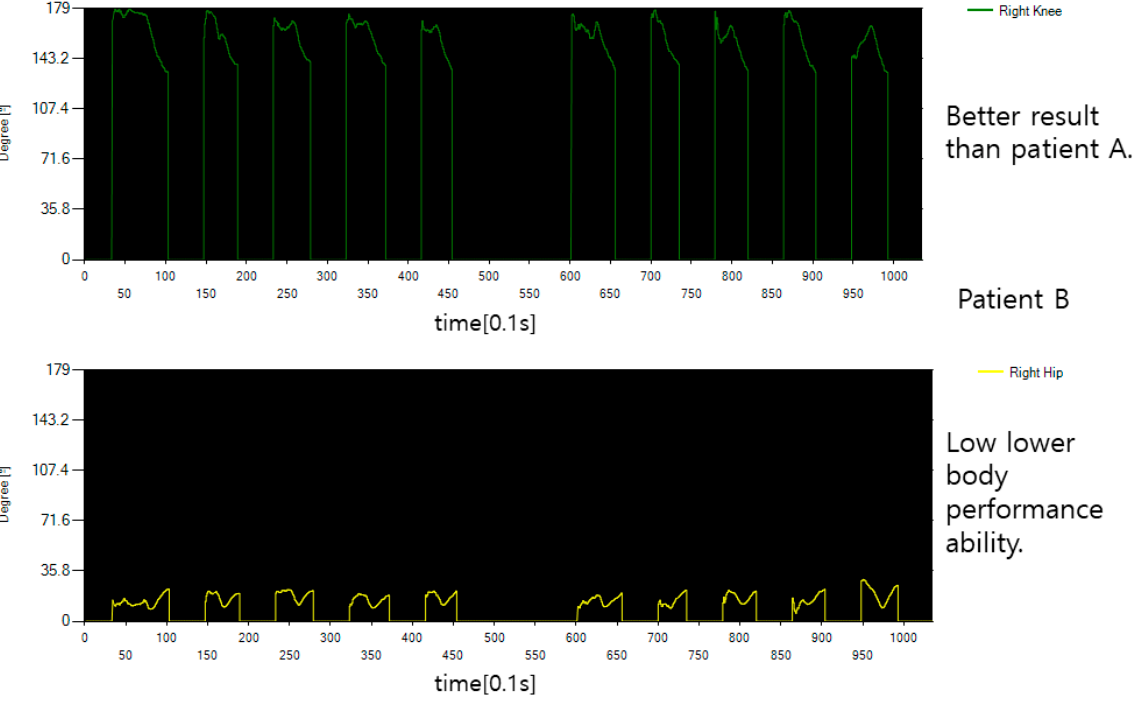
Figure 14. The angle data of patient B’s sitting motion.